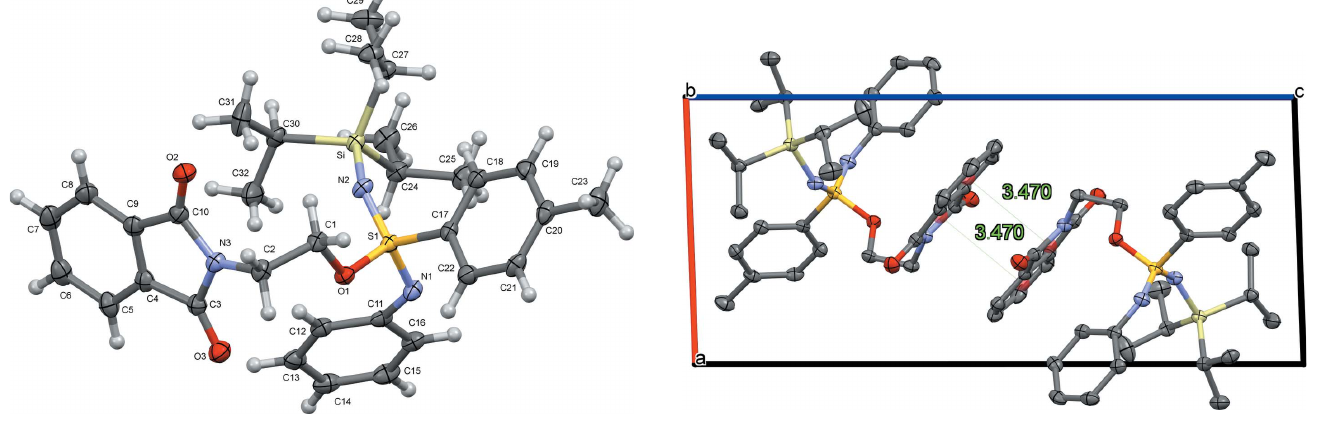
Figure 2 Crystal packing in rac -2-(1,3-dioxoisoindolin-2-yl)ethyl-4-methyl- N - phenyl- N 0 -(triisopropylsilyl)benzenesulfondiimidoate ( 1 ) viewed along the b axis. Antiparallel stacking of the phthalimide occurs with a centroid–centroid distance of 3.470 (1) A˚ . Displacement ellipsoids are drawn at the 50% probability level and H atoms are omitted for